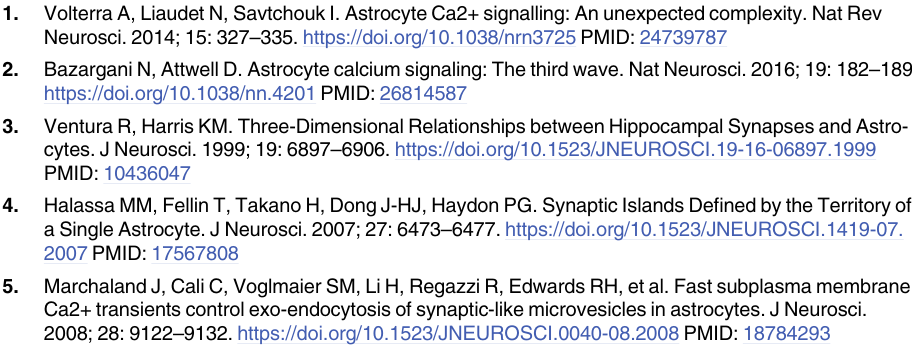
S3 Appendix. Calcium sensors in the gliotransmitter release model. (DOCX) S1 Fig. Time courses of glutamate, IP (DOCX) S2 Fig. Temporal profiles of vesicle release from astrocytic domains in response to various stimuli. (DOCX) S3 Fig. Kinetic schemes of astrocytic calcium sensors (synaptotagmins). (DOCX) S1 Table. Model